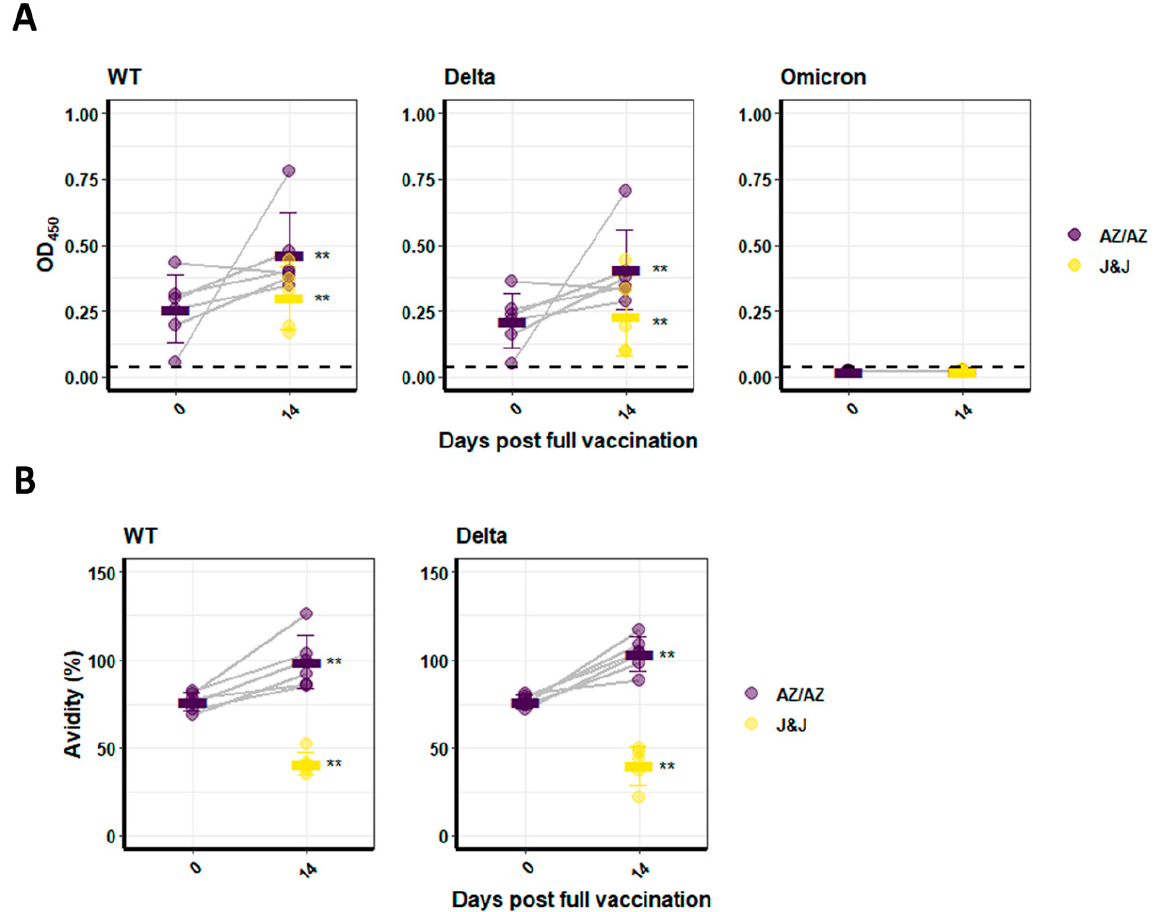
Figure 2. Analysis of RBD binding and IgG avidity in sera . ( A ) IgG binding to the WT, Delta, or Omicron RBD was analysed by ELISA. Binding is depicted as OD 450 values. Binding of IgG after the first and the second AZ vaccination is shown. J&J was applied as a single dose and is depicted in yellow. ( B ) IgG avidity measurements after one or two doses of AZ or one dose of J&J compared to preimmune serum. Omicron RBD avidity could not be determined as it was below background values. Bars indicate the arithmetic mean for each group. Significance is indicated with two stars (**) for a p -value between 0.001 and 0.01.